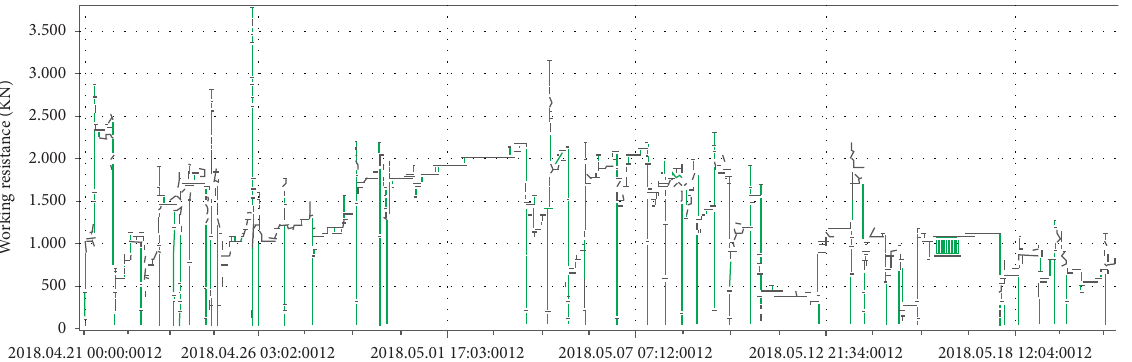
Figure 7: 12 #online monitoring of working resistance of extension support (2018.04.21–2018.05.18).